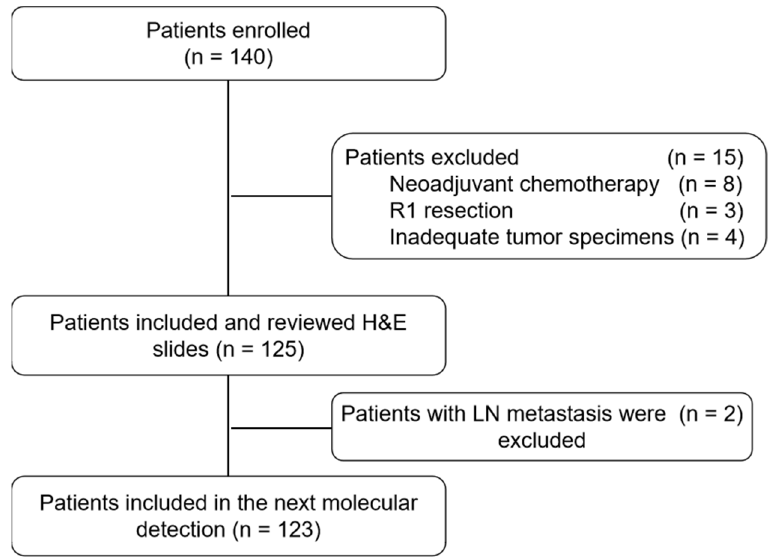
Figure 1. Study scheme. A total of 140 patients were initially quired and 17 patients were excluded because of receiving neoadjuvant chemotherapy (n = 8), R1 resection (n = 3), inadequate tumor specimens (n = 4) or identification of LN metastasis at the time of FFPE block sectioning. Finally, the remaining 123 eligible patients were subjected to subsequent analyses.